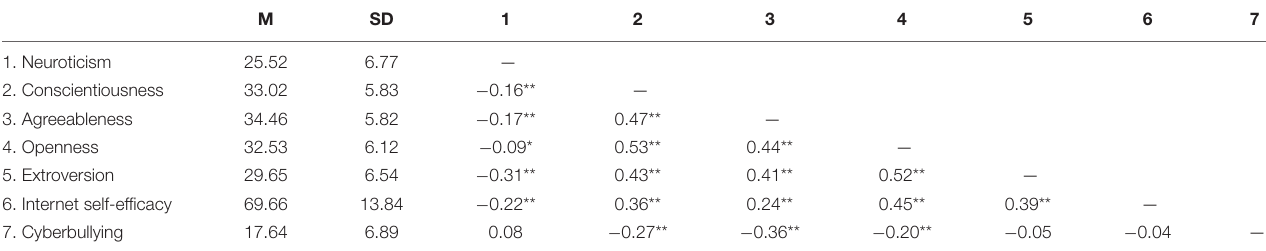
TABLE 1 | Descriptive statistics and correlations among variables.